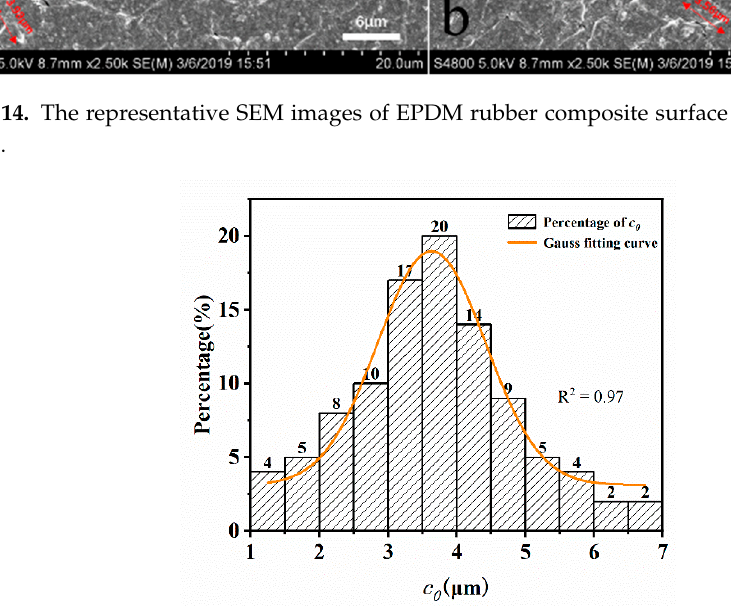
Figure 15. Distributions of the crack precursor sizes.